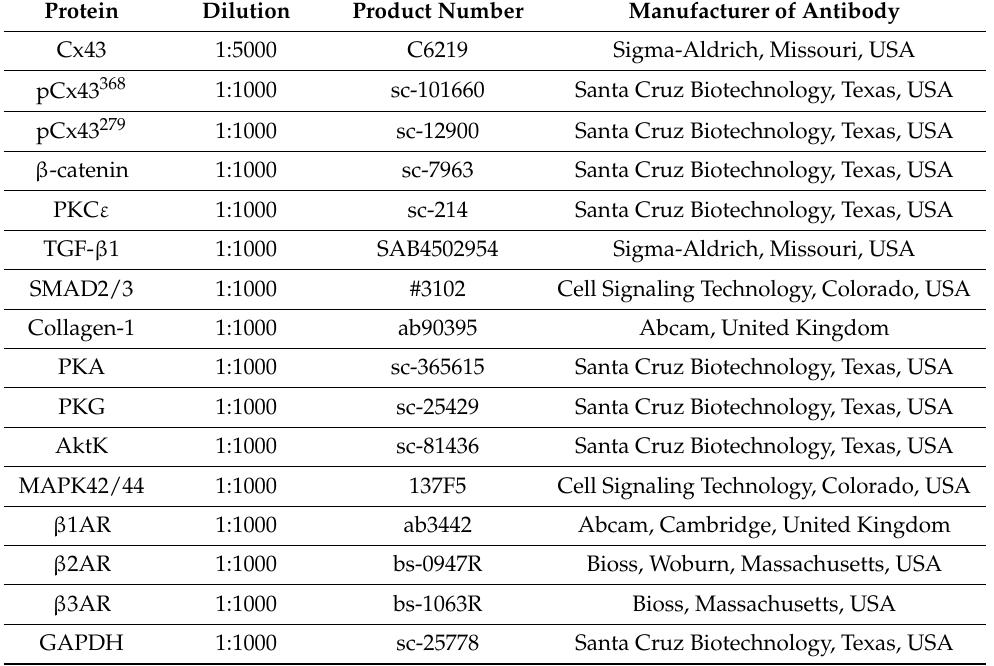
Table 1. List of primary antibodies used for the Western blot detection of